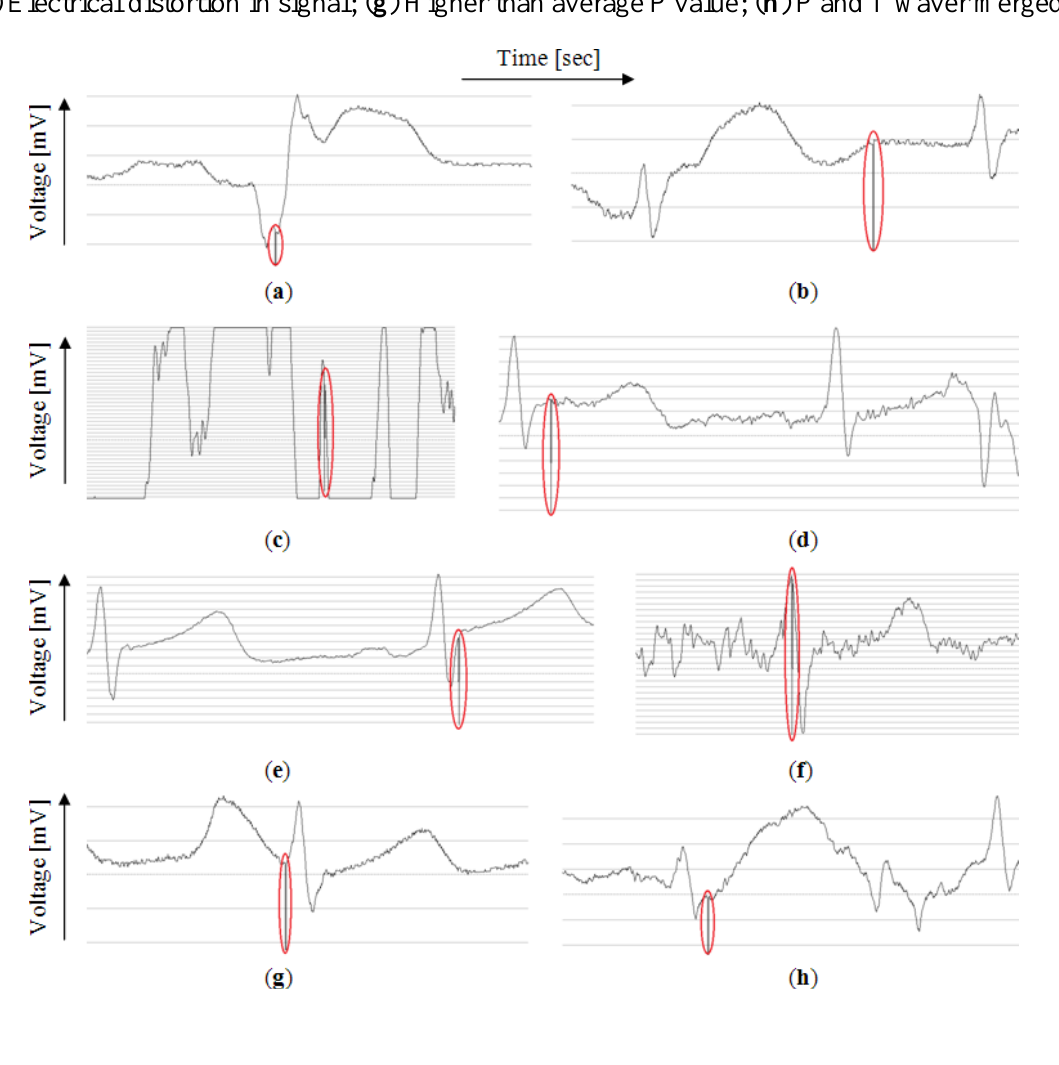
simulation software. ( a ) One faulty beat; ( b ) A series of faulty beats; ( c ) One of the electrodes probably fell off; ( d ) Anomalies in signal shape; ( e ) Higher than average T